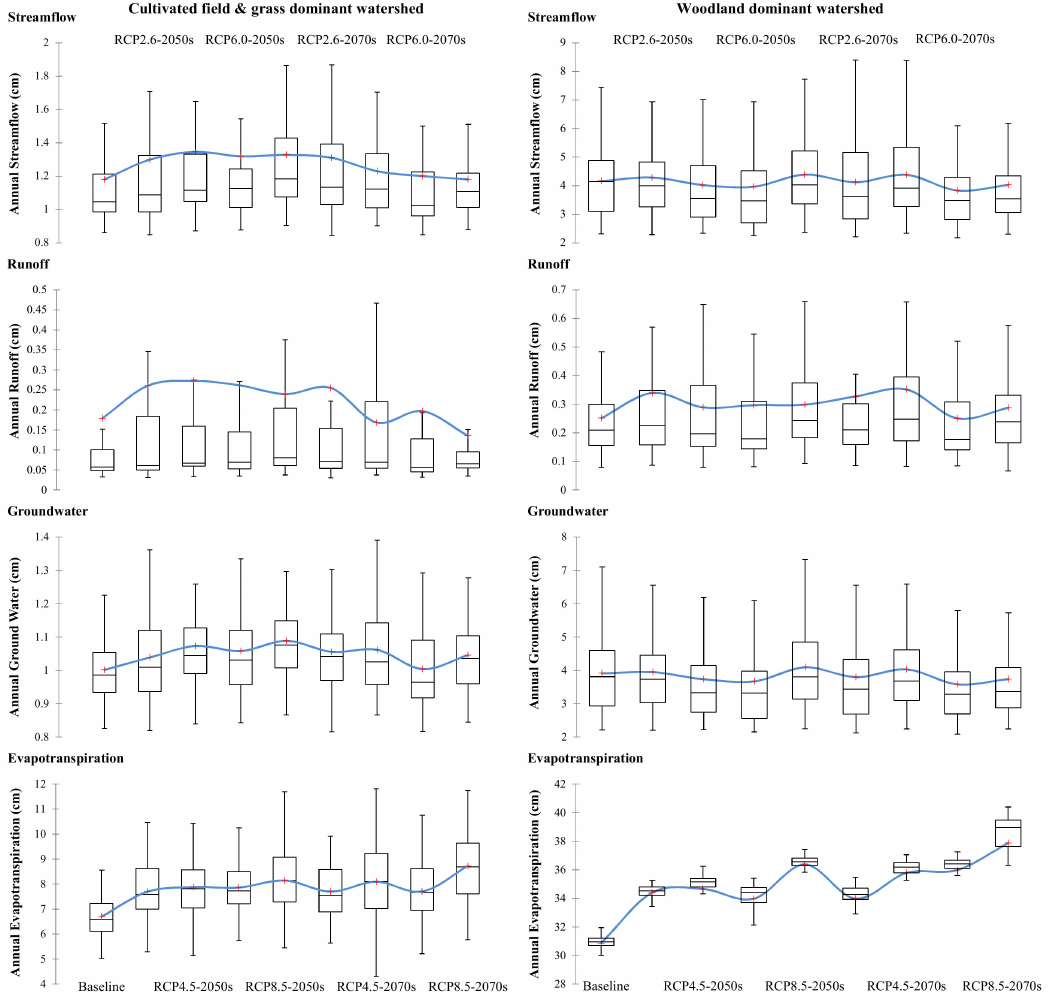
Figure 4. The changes in annual streamflow, runo ff , groundwater and evapotranspiration in response to various future climate changes in the 2050s and 2070s. The upper and lower borders of the box represent the 25th and 75th percentiles; the line and cross in the box interior represent the median and mean values; the “whiskers” represent the lower and upper